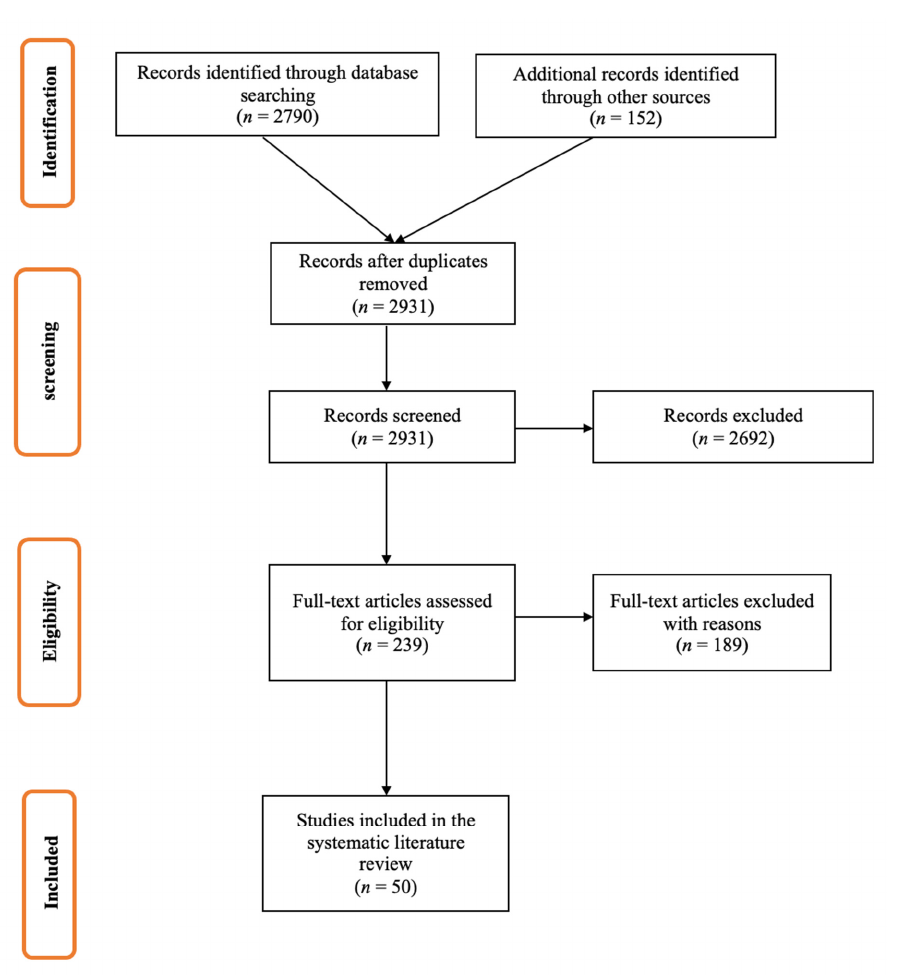
Figure 1. Literature review results for the research question: “Influenza vaccine match (TIVs and QIVs) to circulating viruses between 2014 and 2019”.